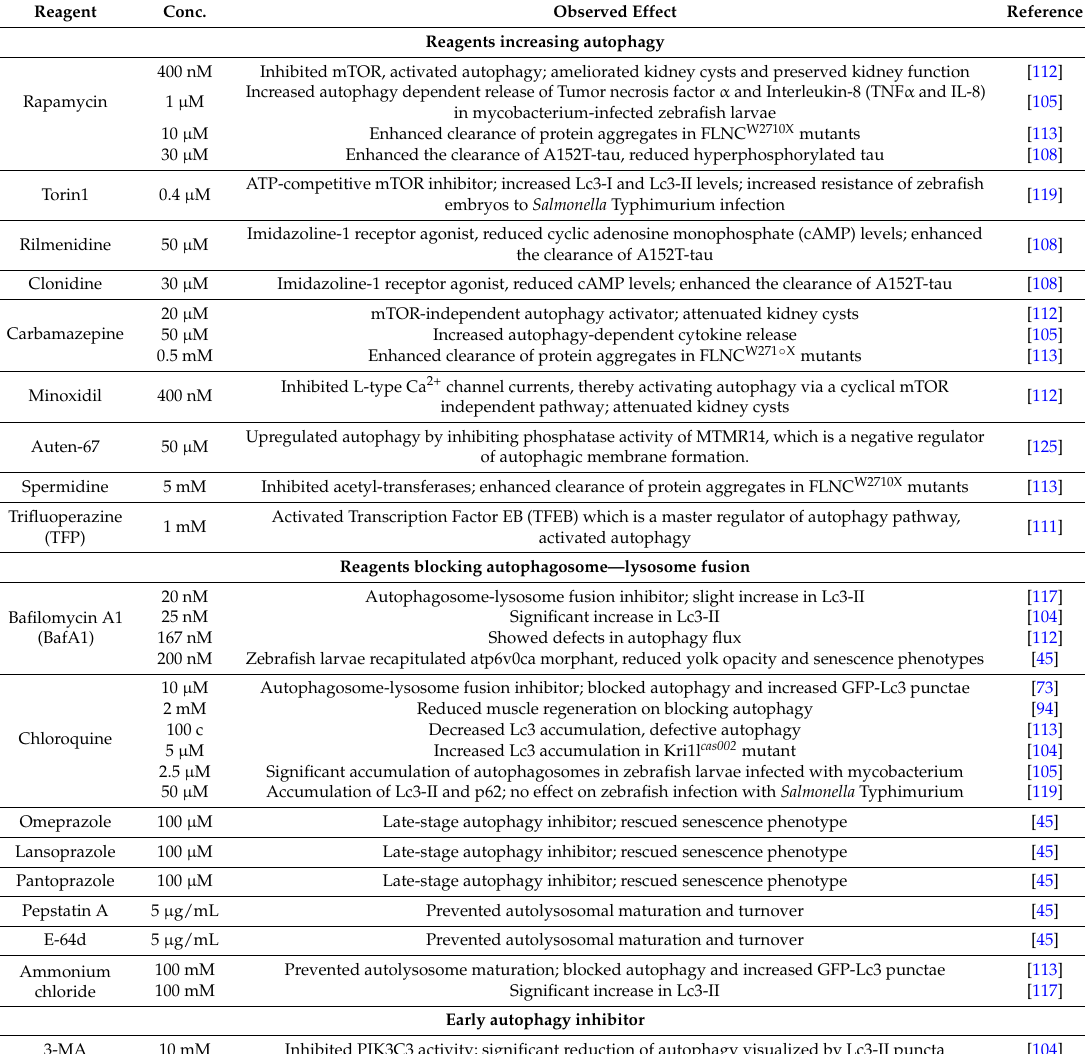
Table 4. List of reagents used to modulate autophagic activity in zebrafish (post–2014). Reagent